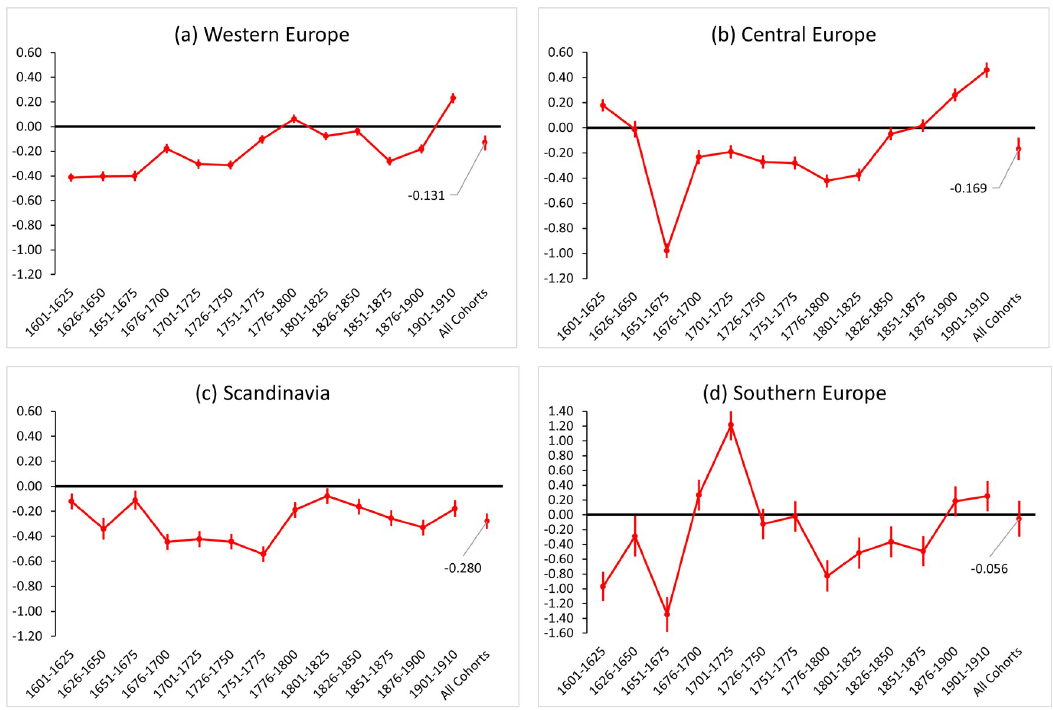
Fig 4. Effect of an additional child on maternal lifespan (in years) by cohorts and regions. Note: Point estimates of the fertility effects on lifespan with 95% confidence intervals are presented. Women’s results are estimated using four regional subsamples and the FECS multilevel Tobit regression models, controlling for age at last